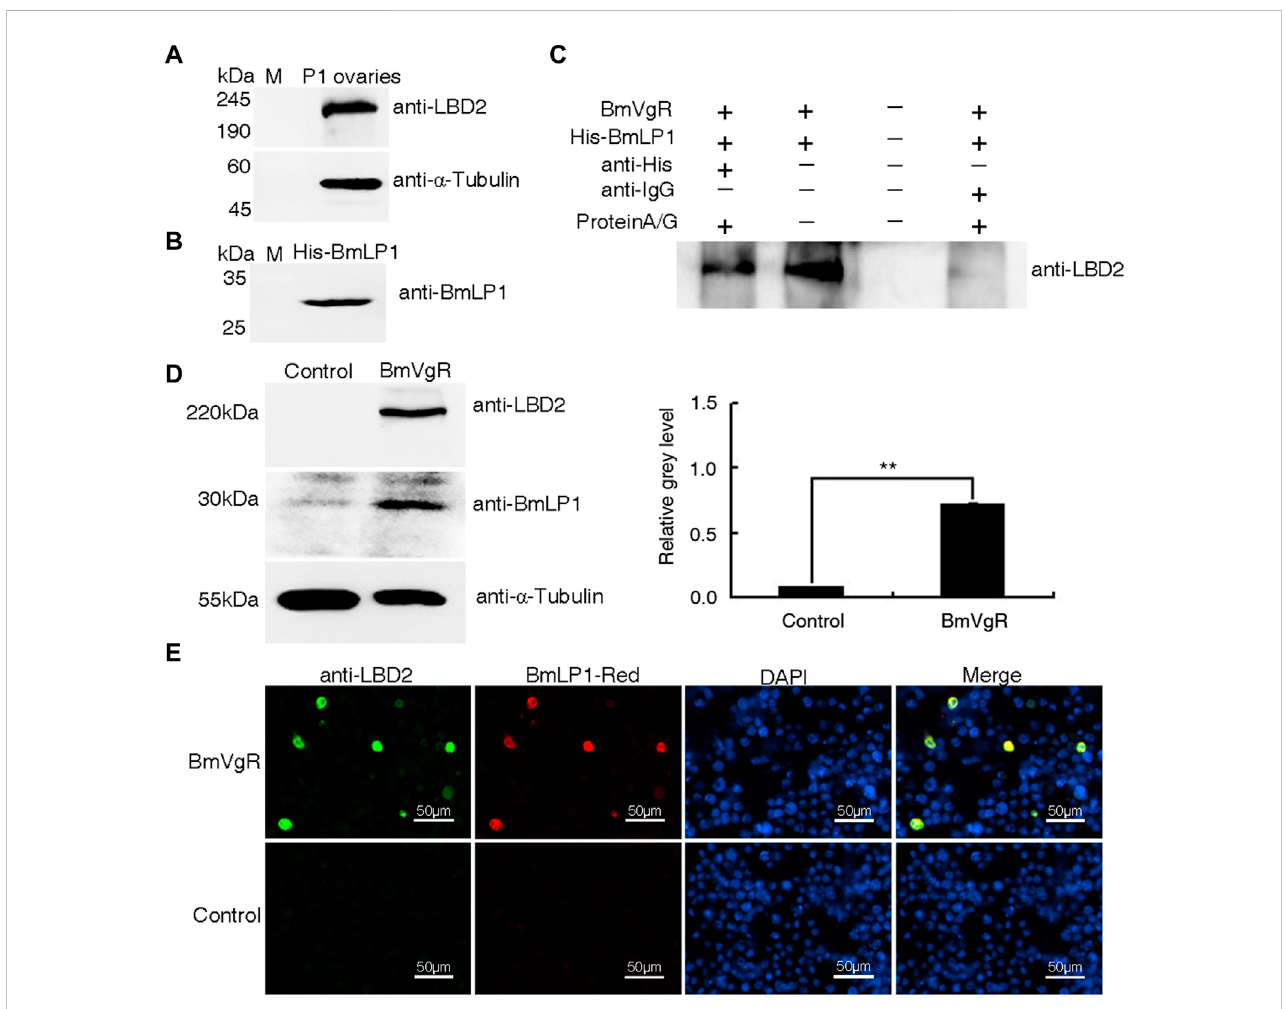
(B) Detection of His-BmLP1 by western blotting. (C) Detection of BmVgR interaction with His-BmLP1 by Co-IP. Lane1, elution from the anti-His beads (sample); Lane2, input BmVgR and His-BmLP1 (positive control); Lane3, last washing buffer for Co-IP (negative control); Lane 4, elution from the